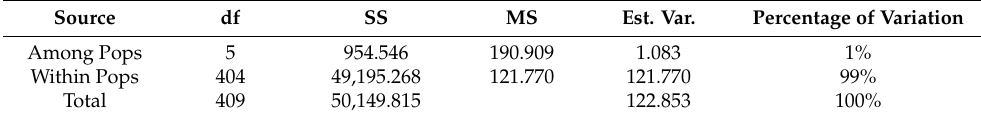
Table 6. Analysis of genetic differentiation among faba bean accessions based on their geographic origin using AMOVA.